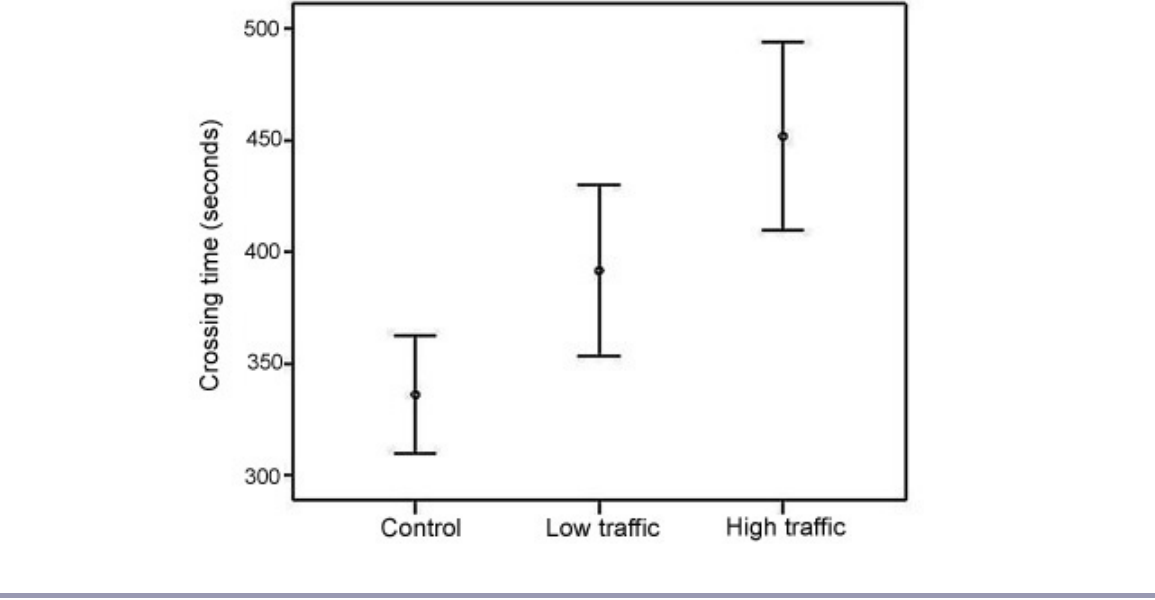
Fig. 2. Mean and 95% CI of the time taken for frogs to cross a 10-m band of habitat at control sites ( n = 60 frogs), and adjacent to low ( n = 62 frogs) and high ( n = 67 frogs) traffic